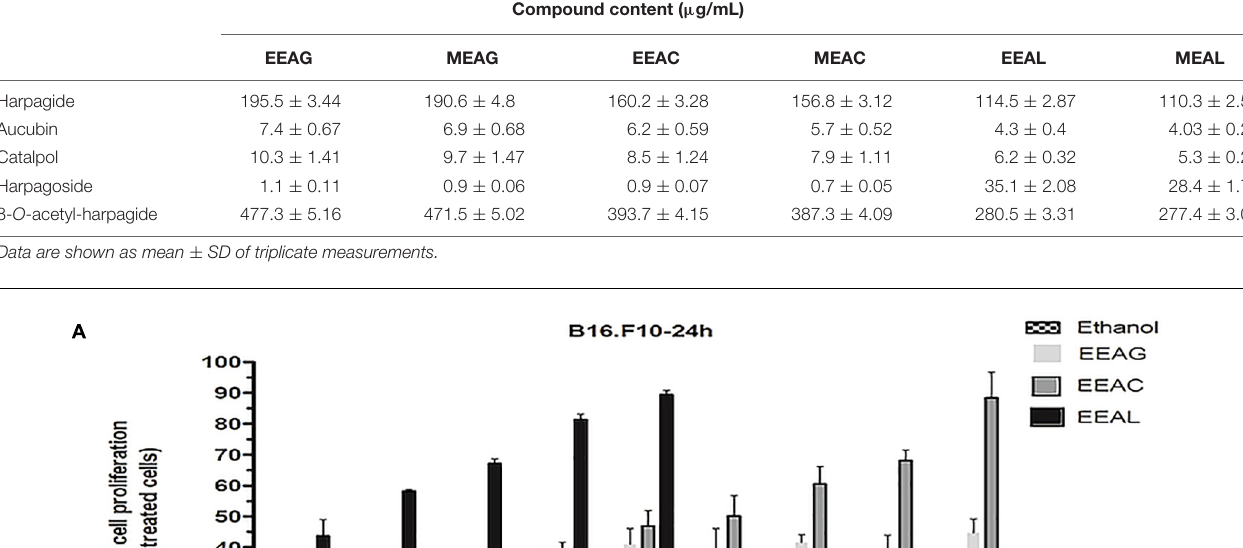
Compound content ( µ g/mL)